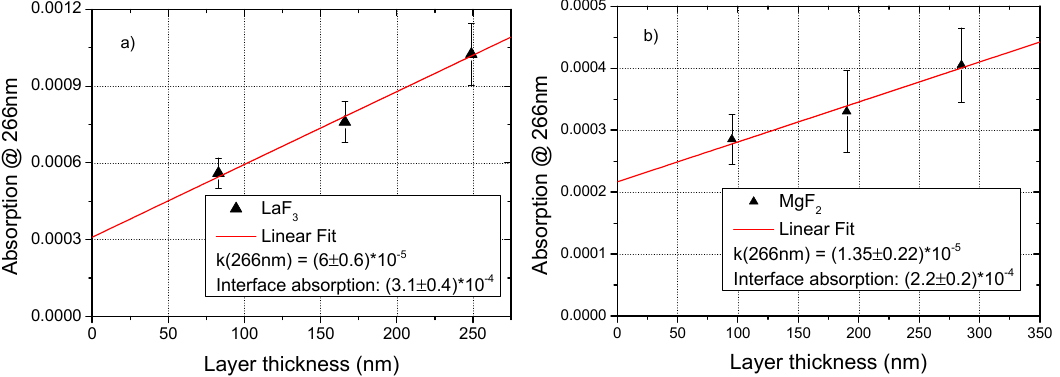
Figure 9. Absorption at 266 nm vs. thin film layer thickness and calculated interface and layer absorption k , respectively, of ( a ) LaF 3 thin films and ( b ) MgF 2 thin films.